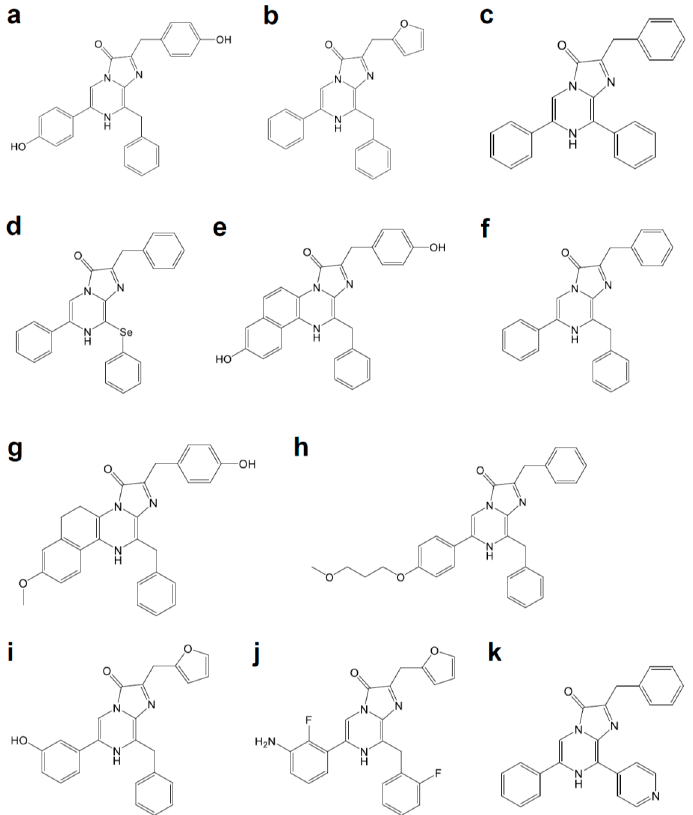
Figure 3. Coelenterazine derivatives for brighter or red-shifted bioluminescence systems: ( a ) Coelenterazine, ( b ) Furimazine, ( c ) Diphenylterazine, ( d ) Selenoterazine, ( e ) Coelenterazine-v, ( f ) DeepBlueC, ( g ) methoxy-eCoelenterazine, ( h ) BBlue2.3, ( i ) Hydrofurimazine, ( j ) Fluorofurimazine, ( k ) 8pyDTZ.